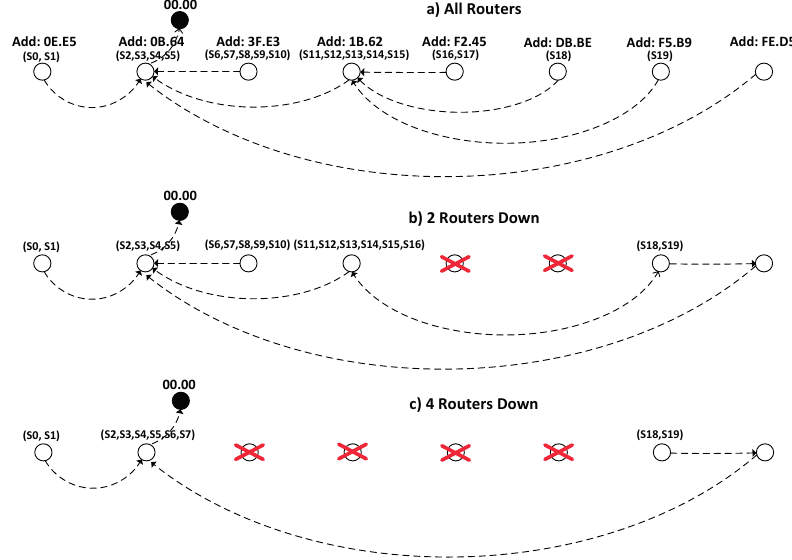
Figure 15. Routes and signals that depend on each router: ( a ) Initial snapshot; ( b , c ) simulating successive drop of